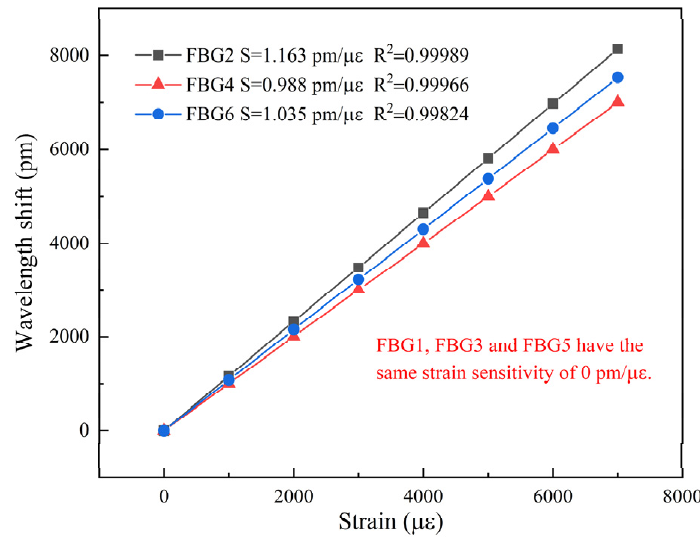
Figure 7. Sensitive performance of different sensing units to strain .